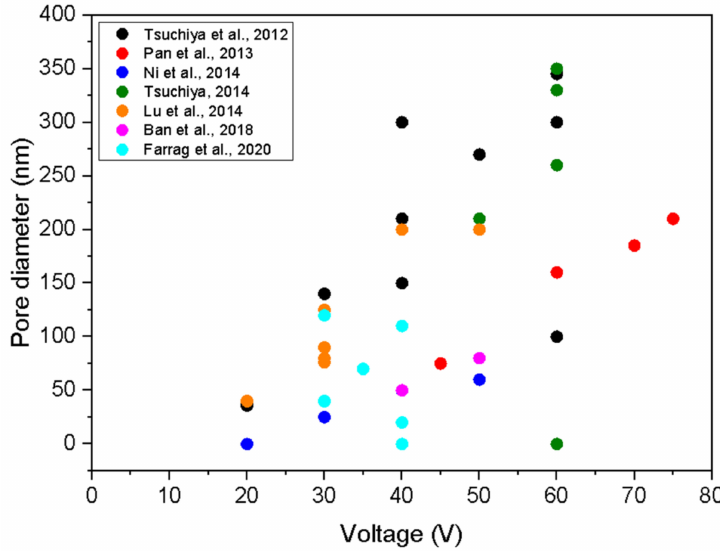
Figure 3. The diameter of nanopores versus the anodisation voltage. Authors and year of publication of the studies stated in the legend are also cited in the references at the end of the manuscript.